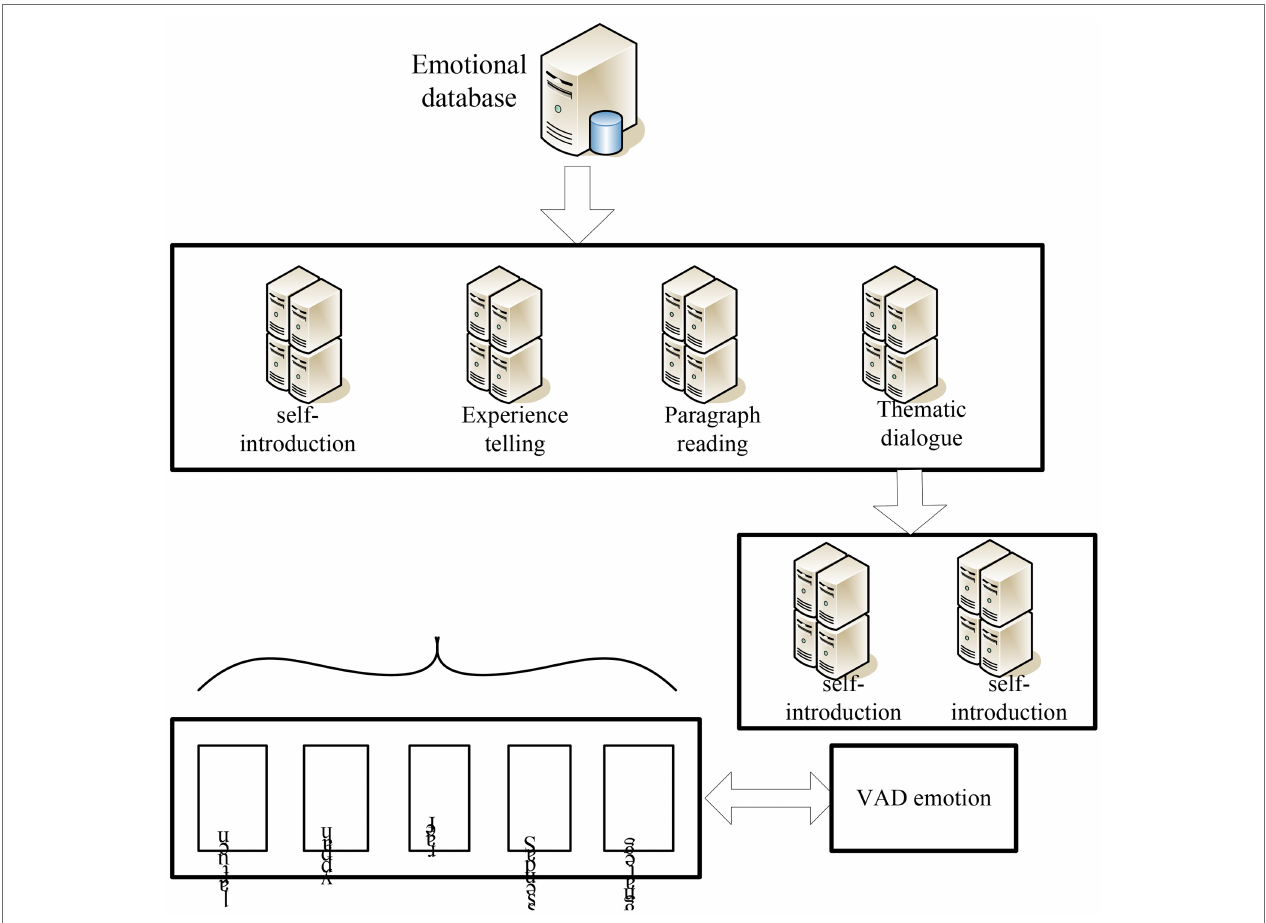
FIGURE 8 | Composition of emotion